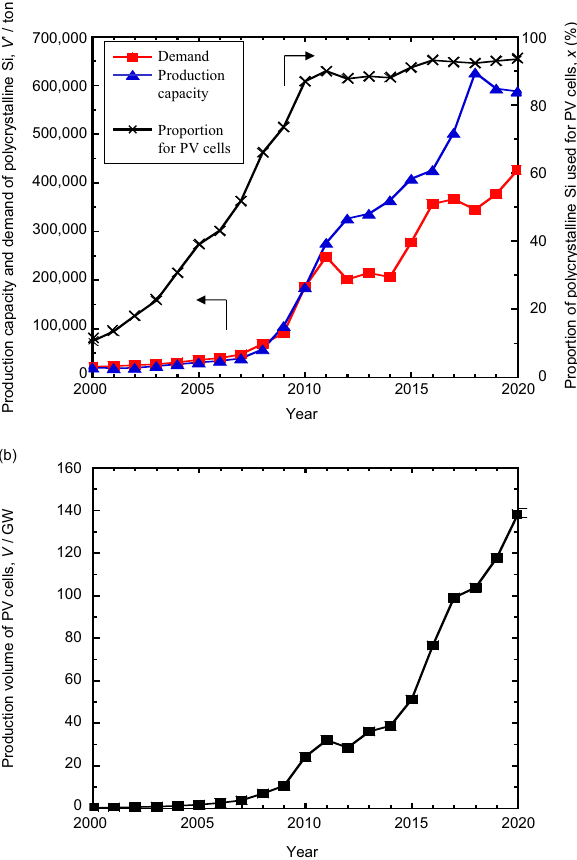
Figure 1: ( a ) Transition in production volume polycrystalline Si in the world and proportion of polycrystalline Si used for PV cells [ 26,27 ] . ( b ) Transition in production volume of PV